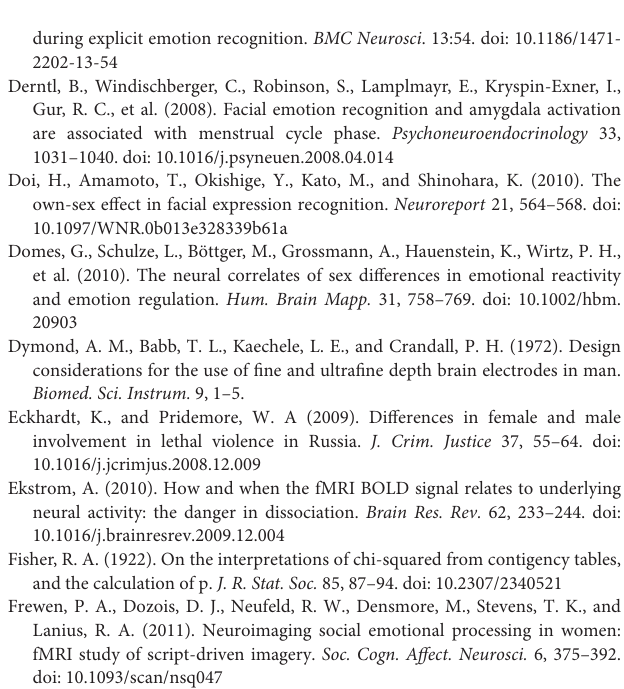
Figure S1 | Tufte-style box plot (21) of mean first response time for each experiment by affect and gender. Response times are grouped by affect and gender. The center dots show intragender means. Vertical lines extend from ( 1 . 58 IQR ) (where IQR interquartile range, n number of observations; ± ∗ √ ( n ) = = equivalent to a 95% confidence interval for differences between medians, Chambers et al., 1983, p. 62) to the data point furthest from the median which is no more than beyond the first or third quartiles. Both males and IQR 1 . 5 (cid:1) ± (cid:0) ∗ females were slowest to identify neutral expressions, and the largest gap in response time was in response to negative faces. Figure S2 | Tufte-style box plot (21) of mean percentage correct of identification of affect of stimuli by experiment. Percentage correct is grouped by gender. The center dots show intragender means. Vertical lines extend from ± ( 1 . 58 ∗ IQR ) (where IQR interquartile range, n number of √ ( n ) = = observations; equivalent to a 95% confidence interval for differences between medians, Chambers et al., 1983, p. 62) to the data point furthest from the median which is no more than beyond the first or third IQR 1 . 5 (cid:1) ± (cid:0) ∗ quartiles. Open circles show responses outside that range. Males had higher accuracy in the expression identification task than females across all categories of